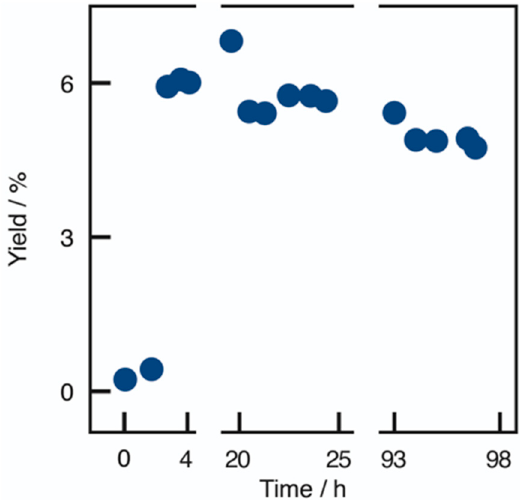
Figure 11. Yield with TA-A50-GA, flow reaction is carried out for periods of ~14 h interrupted by cold storage.